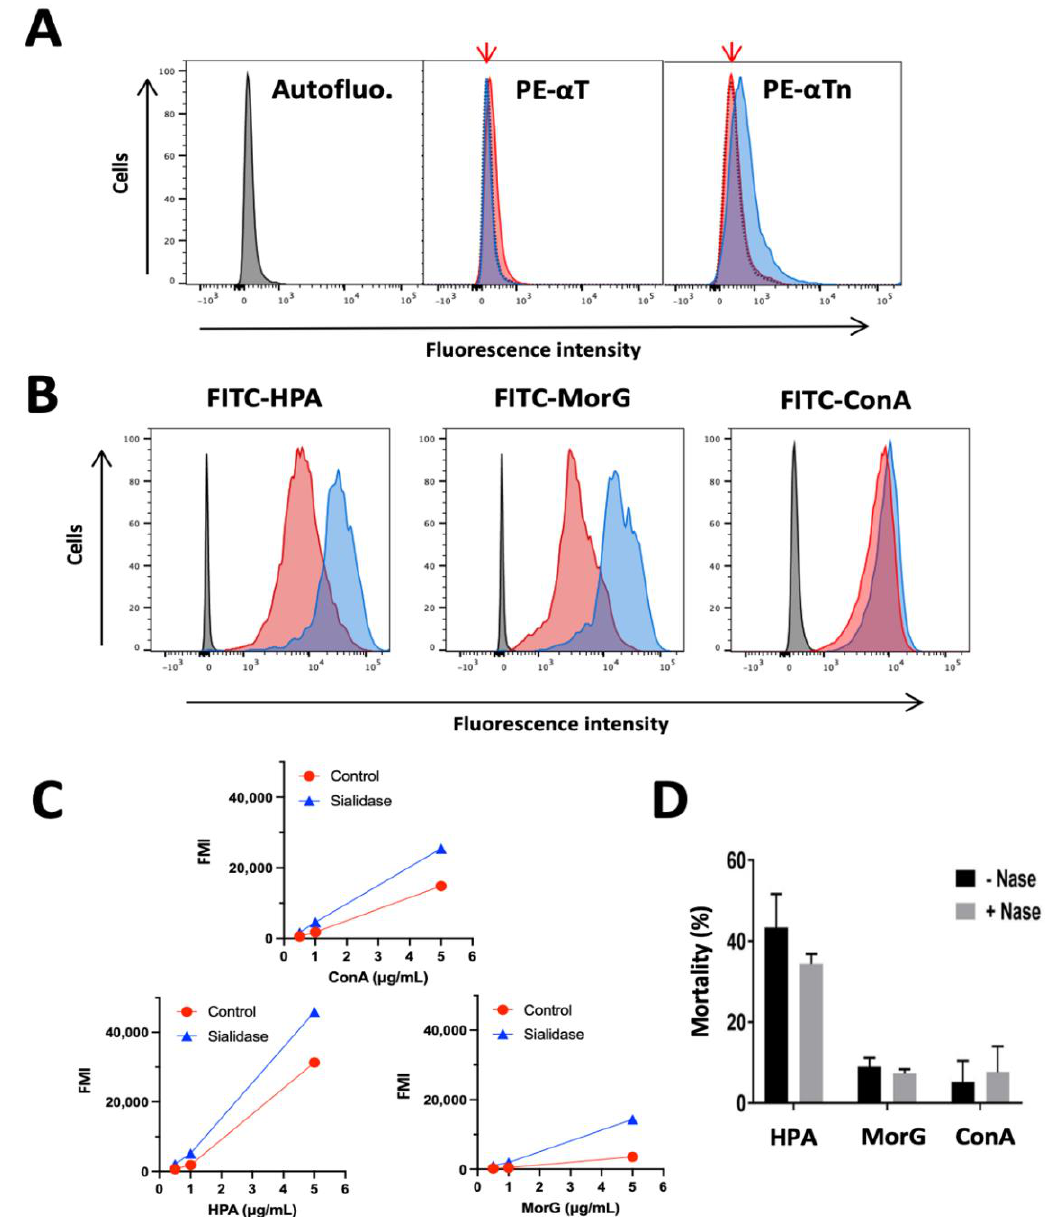
Figure 4. Effect of neuraminidase treatment on glycan detection at EL4 cell surface and lectin-induced cell death: ( A – C ) EL4 cells were incubated with (blue) or without (red) neuraminidase (20 mUI, 30 min, 37 ◦ C) and labeled: ( A ) with anti-Tn (PE- α Tn) or anti-T (PE- α T) mouse monoclonal antibodies or ( B , C ) with FITC-lectins: HPA (FITC-HPA), MorG (FITC-MorG), or ConA (FITC-ConA). ( A ) Red arrow indicates autofluorescence pic position (grey curve); ( B ) representative results of two independent experiments with 5 µ g/mL of labeled lectin, with blue curve corresponding to neuraminidase-treated cells; and ( C ) lectin concentration effect on labelling. ( D ) EL4 cells were incubated with (+ Nase) or without ( − Nase) neuraminidase, washed, and cultured for 48 h with 2.5 µ g/mL of HPA, MorG, or ConA, then cell death was analyzed using cytofluorimetry. Results are means ± SD of three independent